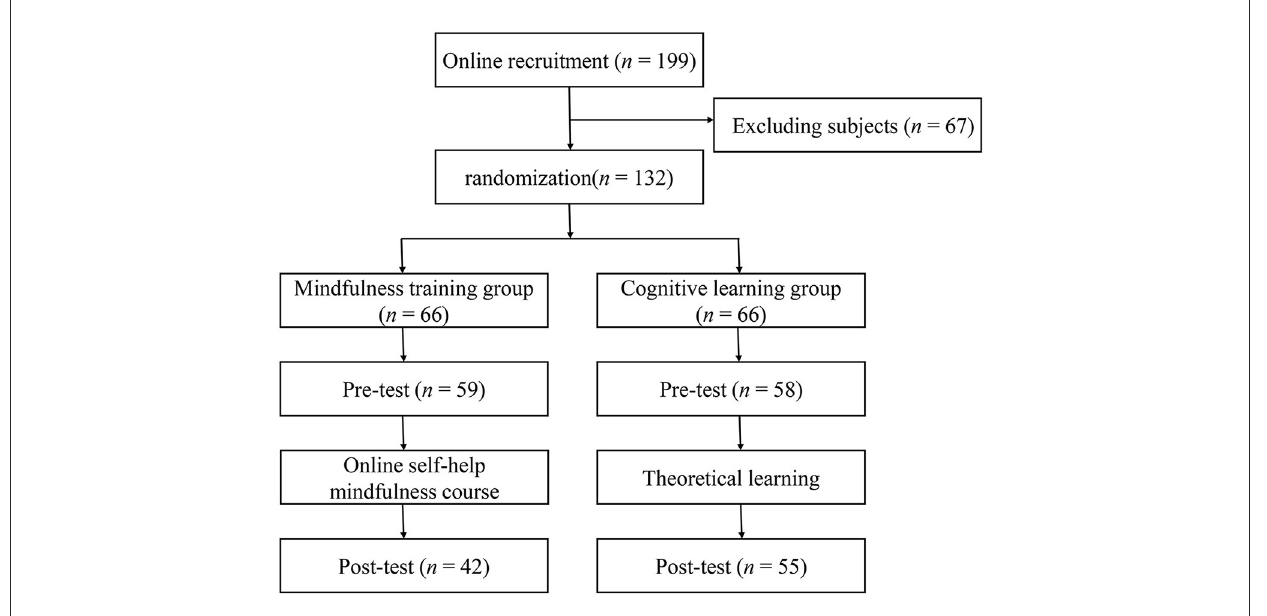
FIGURE1 The flow chart of the study in Phase